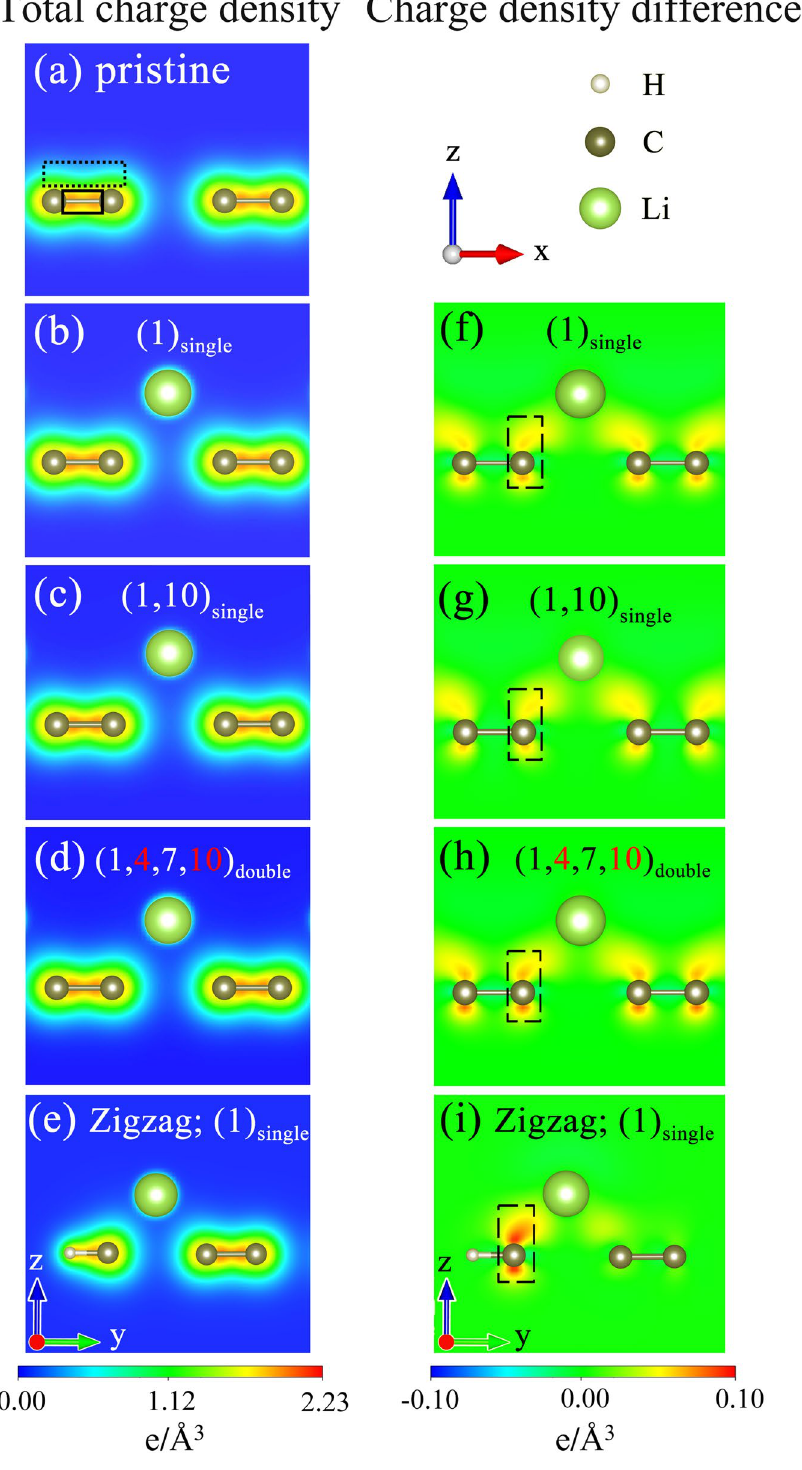
Figure 5. The spatial charge distributions of N A = 12 armchair systems for ( a ) a pristine GNR, ( b ) an adatom at edge (1) single , ( c ) two adatoms at (1, 10) single and ( d ) four adatoms at (1, 4, 7, 10) double . The π and σ bondings are, respectively, enclosed by the dashed and solid rectangles. The charge density differences, corresponding to ( b – d ), are revealed in ( f – h ), respectively. Also shown in ( e ) and ( i ) are those of N z = 8 zigzag system with an